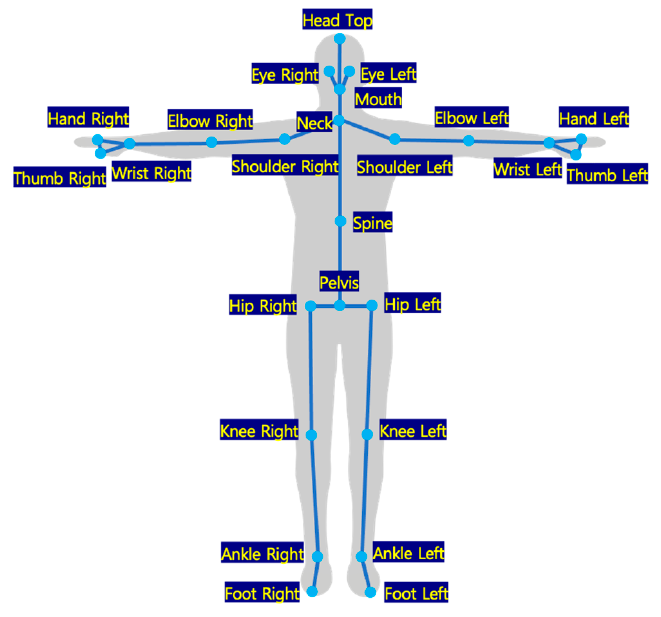
Figure 5. Definitions of joints.